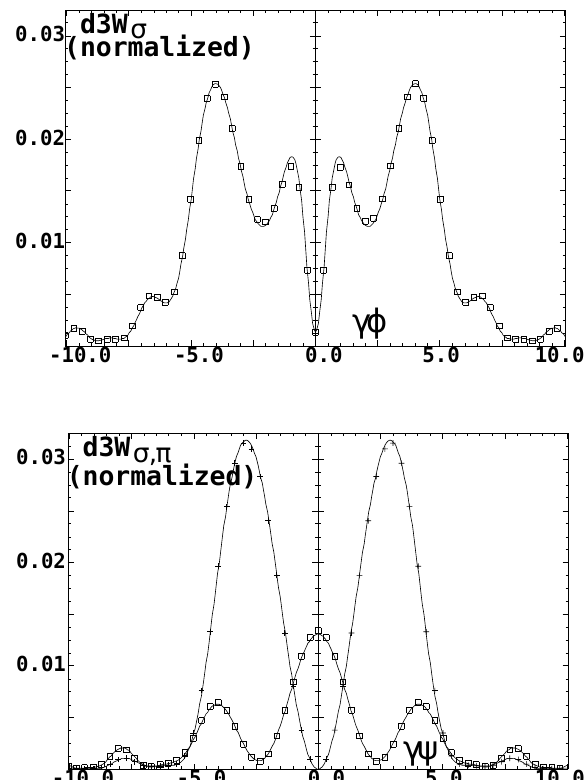
FIG. 12. Wiggler low frequency SR (section views of Fig. 7). Top: ≠ 3 W s (cid:4) ≠v≠w≠c vs gw at gc (cid:2) 0 . Bottom: ≠ 3 W s , p (cid:4) ≠v≠w≠c vs gc at gw (cid:2) 2.5 . Solid lines are from Eq. (22) while squares ( s component) and crosses ( p component) are from numerical simulations. Here v ø v limit . The excellent behavior of the low frequency SR formalism up to large ( f , c ) ranges well beyond significant energy density levels is evident.